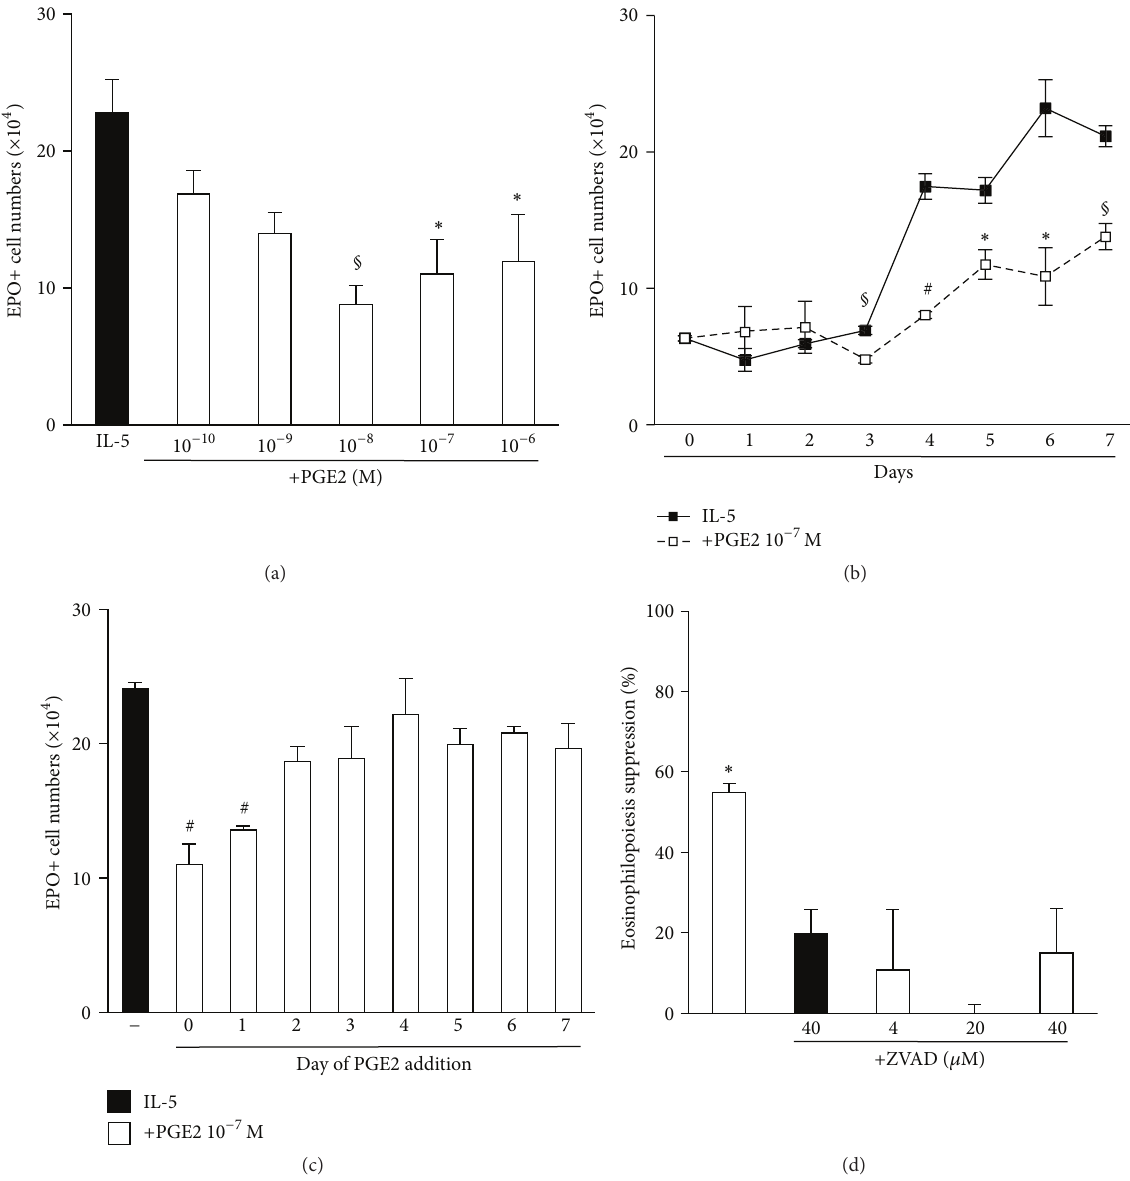
Figure 1: PGE2 suppresses eosinophilopoiesis by activating a caspase-dependent mechanism. Bone-marrow cultures were established in the presence of IL-5, alone or associated with PGE2, caspase inhibitor zVAD-fmk, or both. All cultures were maintained for 7 days, except for (b). All agents were added at the beginning of the culture, except for (c). Data (mean + SEM; 𝑛 = 3 ) are the numbers of EPO+ cells recovered at the end of the culture ((a)–(c)) or the % eosinophilopoiesis suppression in the indicated conditions, where inhibitors were used to prevent this suppression (d). Significant differences relative to the respective IL-5 controls: ∗ 𝑃 ≤ 0.05 , ∗∗ 𝑃 ≤ 0.01 , § 𝑃 ≤ 0.005 , # 𝑃 ≤ 0.0025